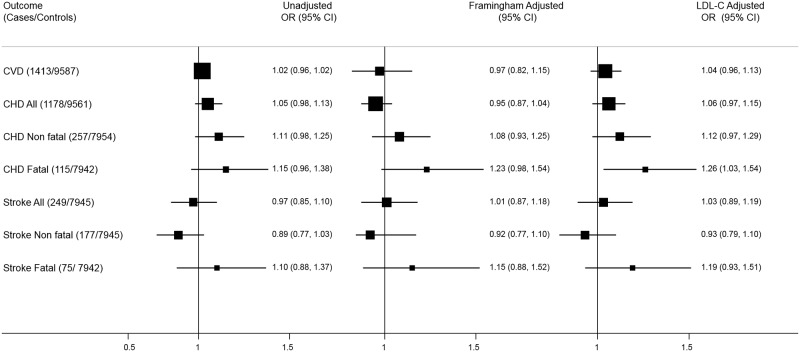
Meta-analysis of association of ApoE level with coronary heart disease and stroke.Adjusted (for Framingham variables) and unadjusted summaries are given separately. ORs represent per SD change of ApoE. Numbers of events and total numbers included in each analysis are given in S4 Table. CHD, coronary heart disease; CVD, cardiovascular disease; LDL-C, low-density lipoprotein cholesterol; OR, odds ratio; SD, standard deviation.